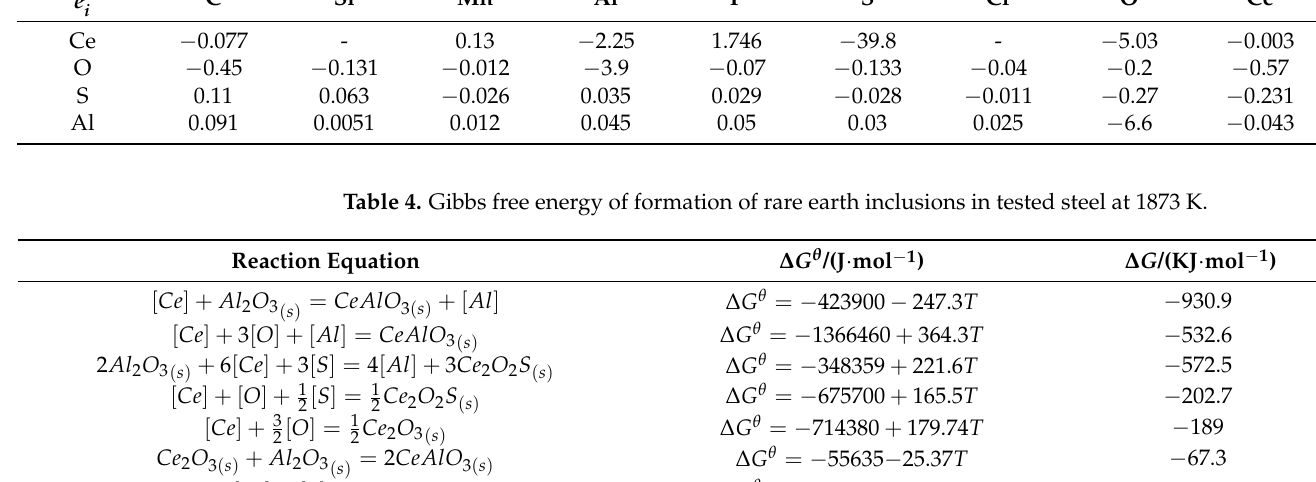
Table 3. Interaction coefficient e j